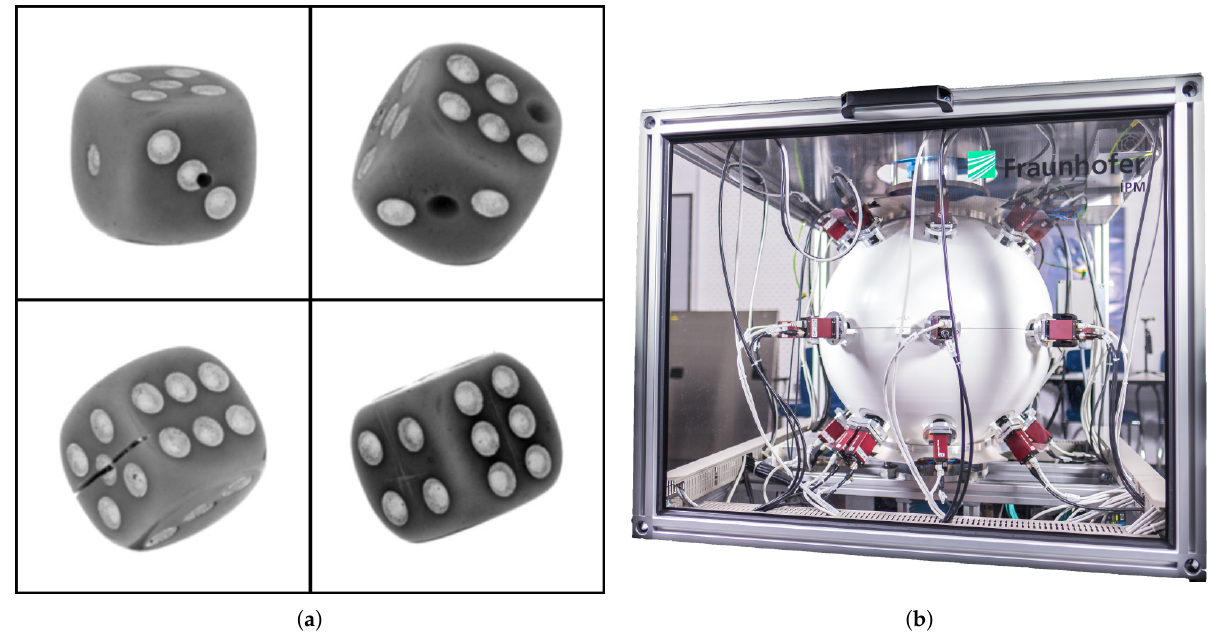
Figure 3. ( a ) Four different types of anomalies were generated for dices: Drilling (17% occurances in test dataset), missing dots (33%), sawing (17%) and scratching (33%). ( b ) The measurement setup free-fall [34] where all 27 cameras are directed to the center of the